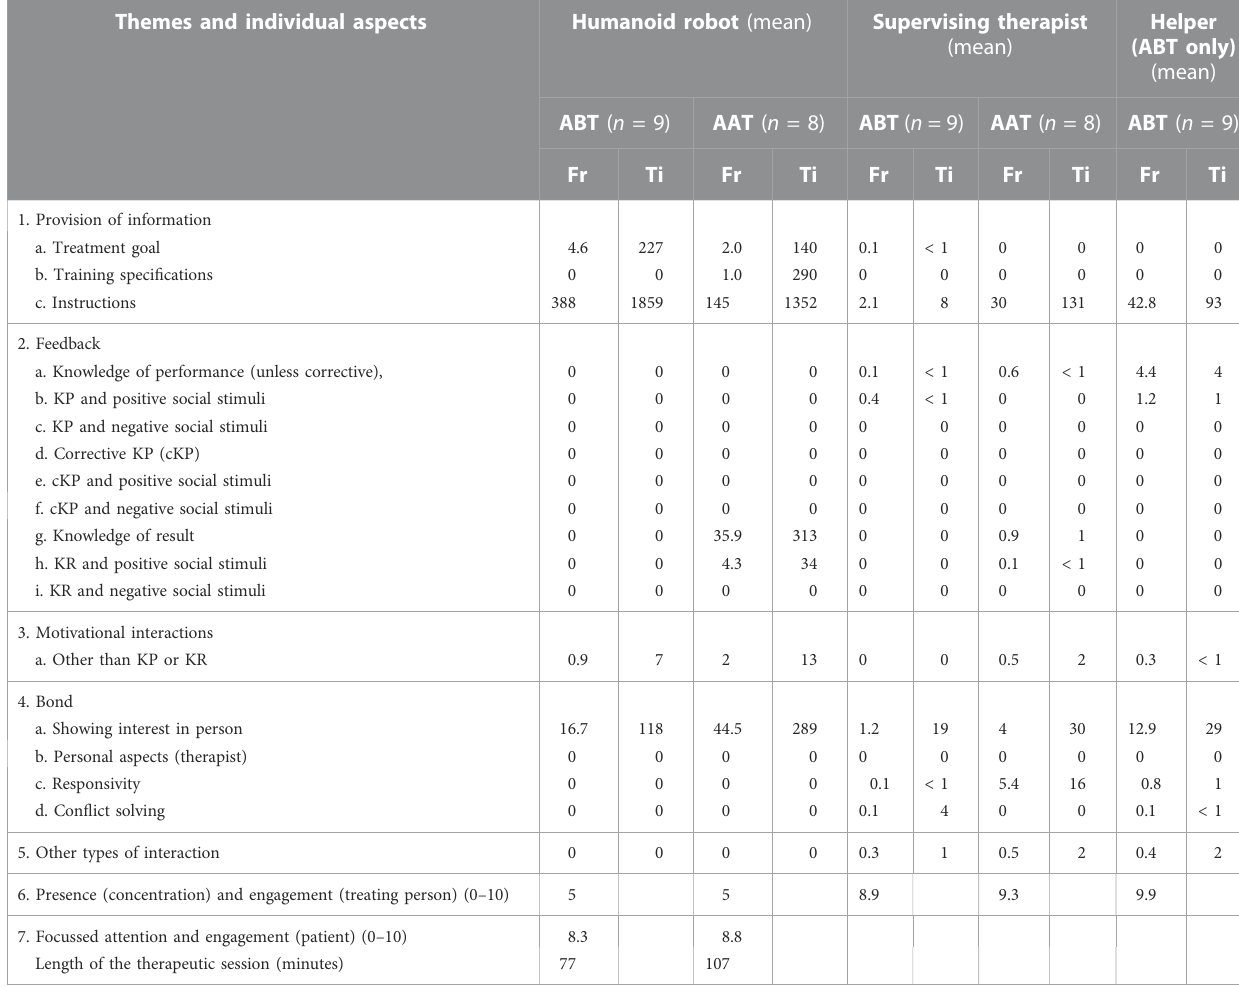
TABLE 2 Ther-I-Act observations: Therapeutic interaction by the humanoid robot, supervising therapist, and helper (day 1) ( n = 17). Themes and individual